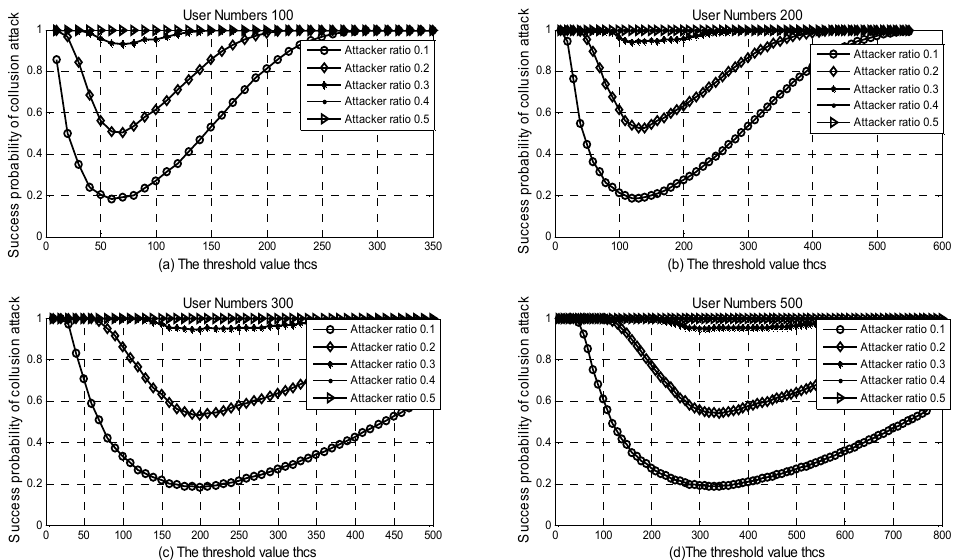
Figure 6. Collusion attacks to prevent the revocation of a malicious public key. Panels ( a – d ) show the success probability fluctuation of this kind of collusion attack when user number is 100, 200, 300, and 500.